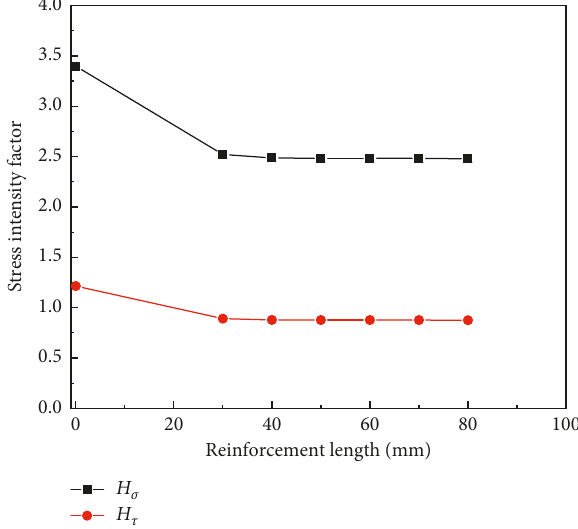
Figure 7: Stress intensity factor-reinforcement